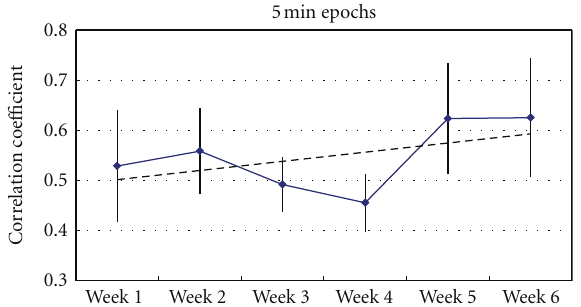
Figure 6: The trend of Pearson correlation coe ffi cients with 5- minute epochs during 6